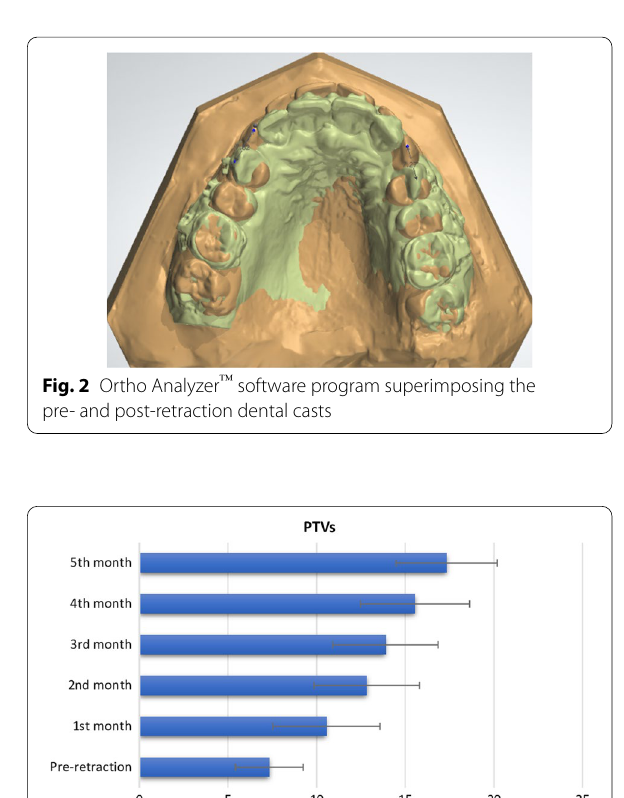
Table 1 Means, standard deviations, the changes in the PTVs prior to canine retraction and the 5th month and the p value of the paired Student’s t test